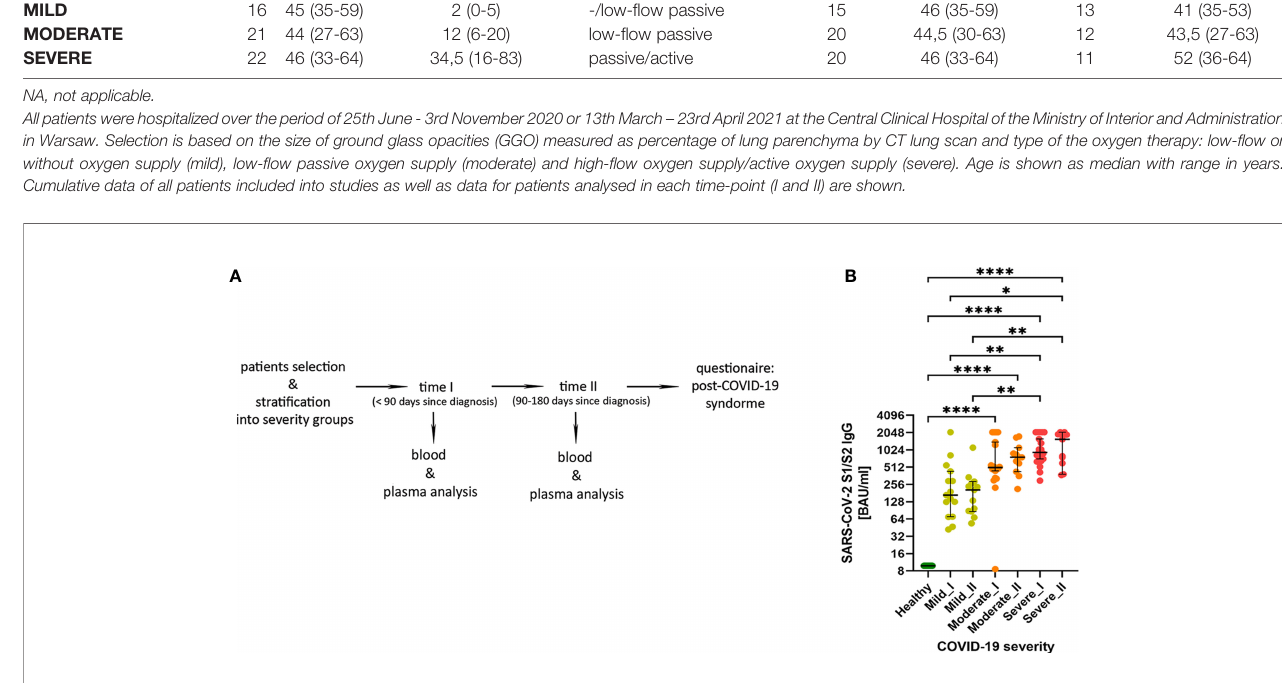
FIGURE 1 | (A) The experimental pipeline. (B) IgG antibodies against SARS-Cov-2 S1/S2 antigens in COVID-19 convalescent individuals. Type of severity (mild, moderate and severe) as well as time-points (I or II) are indicated. Data shown in the log2 scale represent individual values, median +/- 95% CI (con fi dence